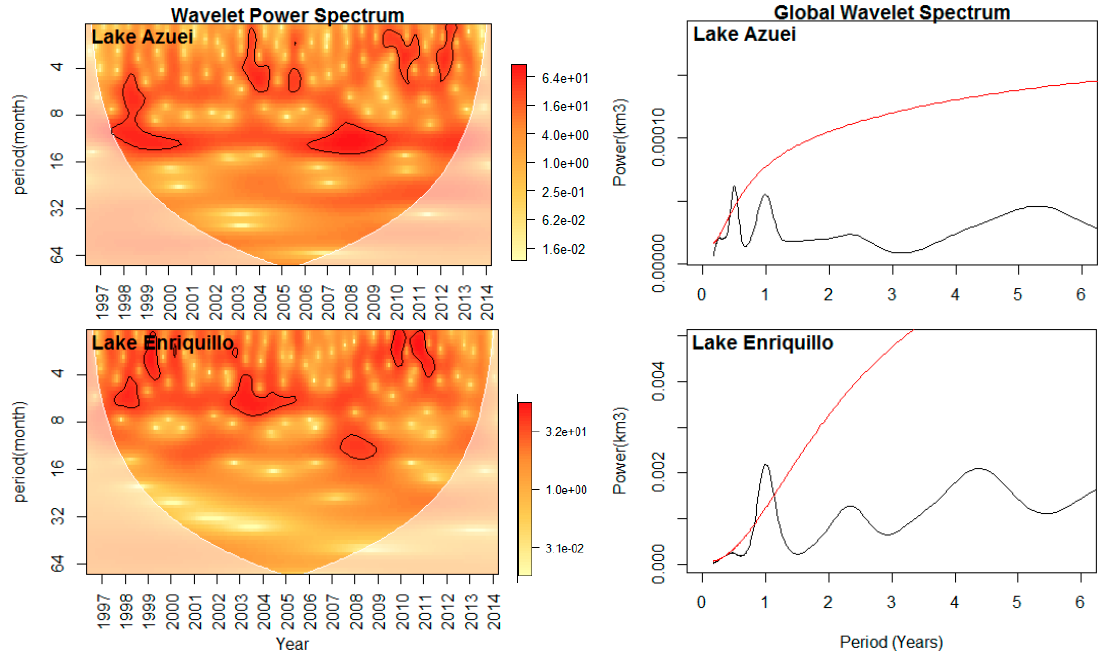
Figure 8. Wavelet power spectrum, CWT, (left), and global wavelet, GWPS, (right) for Lake Enriquillo and Lake Azuei. [(1) Plots on the left: shades of colors are wavelet power (The darker the color, the stronger the power of the scale), lighter shaded area: the Cone of Influence (COI) where edge effect is important, black contour: the 5% significance level; (2) Plots on the right: red line is the 95% confidence level of a red-noise process].